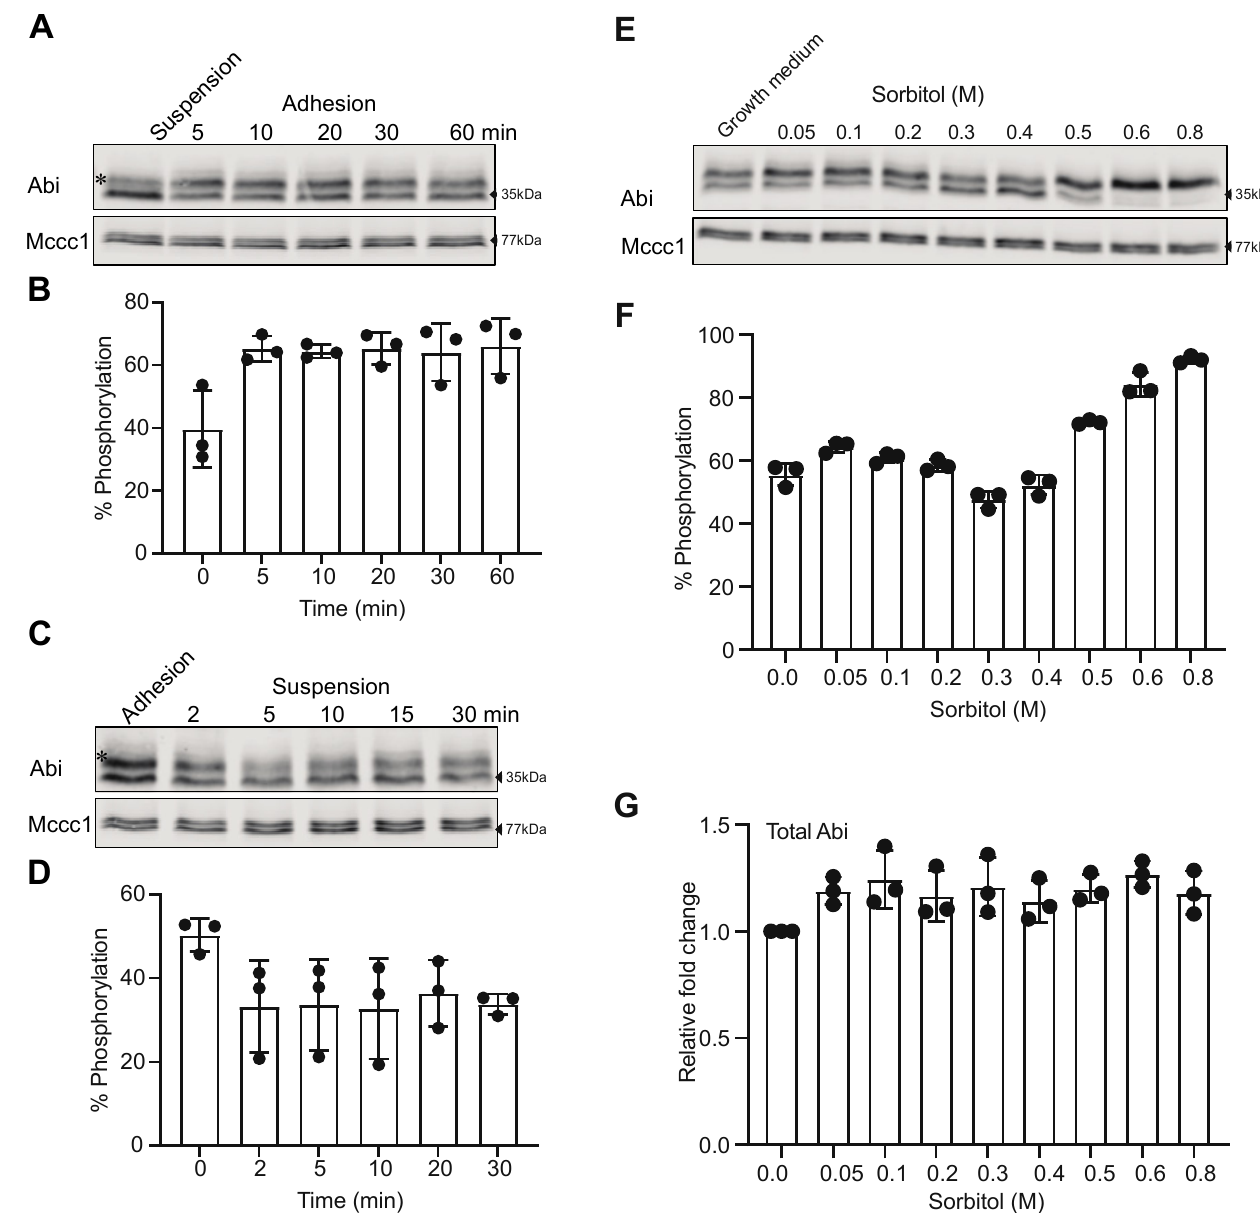
Figure 3. Cell-substrate adhesion enhances Abi phosphorylation. ( A , B ) Effect of adhesion on Abi phosphorylation. Suspension grown cells were allowed to adhere in Petri dishes and then lysed at indicated time points, and cell lysates were analyzed by Western blotting. The intensity of the upper Abi band (*) increases after adhesion. Quantitation of lane band intensities (intensity of “upper bands”/total band intensity; mean ± SD, n = 3, p = 0.0082, Ordinary one-way ANOVA) confirms increased intensities of phosphorylated Abi bands after adhesion ( B ). ( C , D ) Effect of de-adhesion on Abi phosphorylation. Cells grown in adhesion on Petri dishes were detached by a jet of medium from a 10 mL pipette, collected and maintained in suspension (approx. 2 × 10 6 cells/mL) by shaking at 120 rpm. Cell lysates were analyzed by Western blotting. Quantitation of lane intensities (mean ± SD, n = 3, p = 0.19, Ordinary one-way ANOVA) confirms a loss of phosphorylated Abi bands (*) intensity ( D ). ( E – G ) Effect of various sorbitol concentrations on Abi phosphorylation. Medium from cells was replaced with PB containing various concentrations of sorbitol. After 5 min cell lysates were prepared in sample buffer and analyzed for Abi ( E ) band shifts. Abi phosphorylation is abolished at 400 mM sorbitol and induced with >400 mM sorbitol ( F ; mean ± SD, n = 3, p = 0.0001, Ordinary one-way ANOVA) without affecting total Abi concentration ( G ; mean ± SD, n = 3, p = 0.3, Ordinary one-way